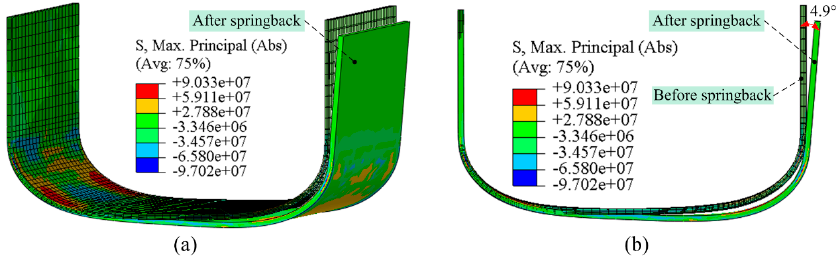
Figure 7. Springback after coil discharge at 1.5 kV: ( a ) 3D view; ( b ) 2D view profile.